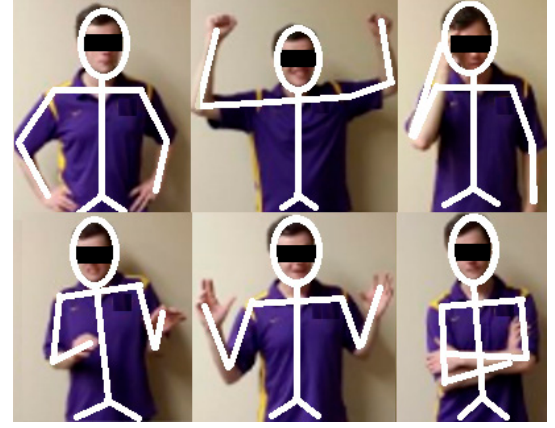
Figure 6. Spontaneous emotions and corresponding body form.